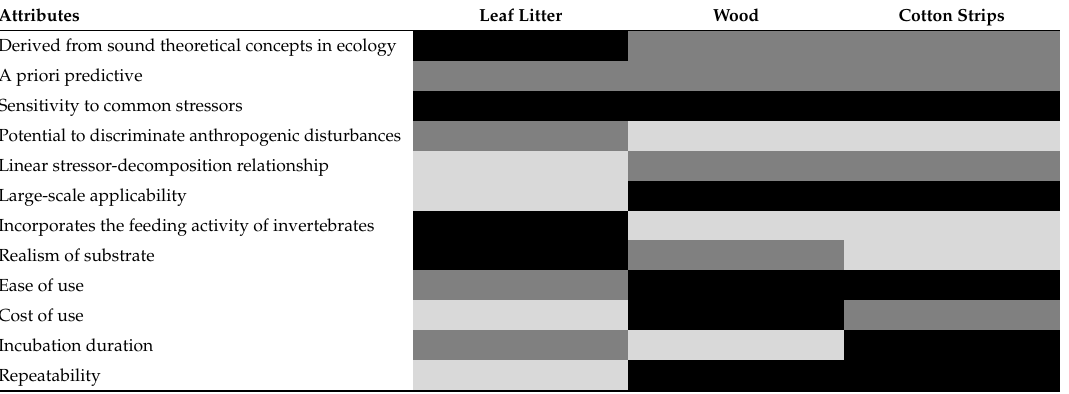
Table 1. Attributes for leaf litter, wood, and cotton strips as they relate to bioassessment. The performances of each substrate, based on our opinion, rank from weak (light grey) to moderate (dark grey) to strong